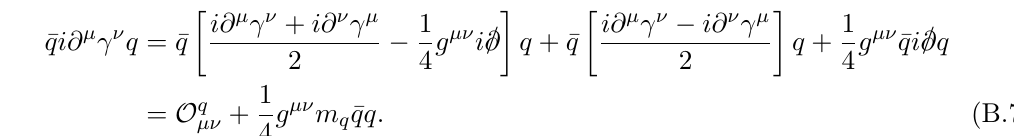
Then, we perform the irreducible decomposition to these